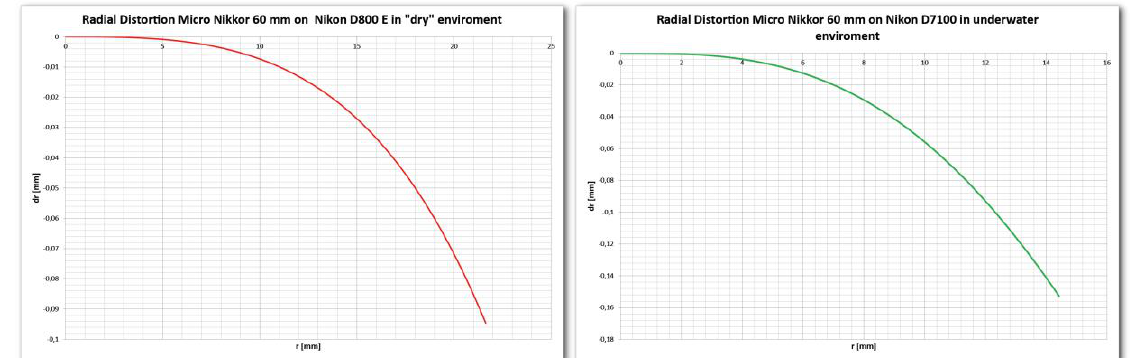
Figure 3. Radial Distortion profiles for Nikon D800E and Nikon D7100, with the same Micro Nikkor 60 mm lens, respectively in dry and underwater environments